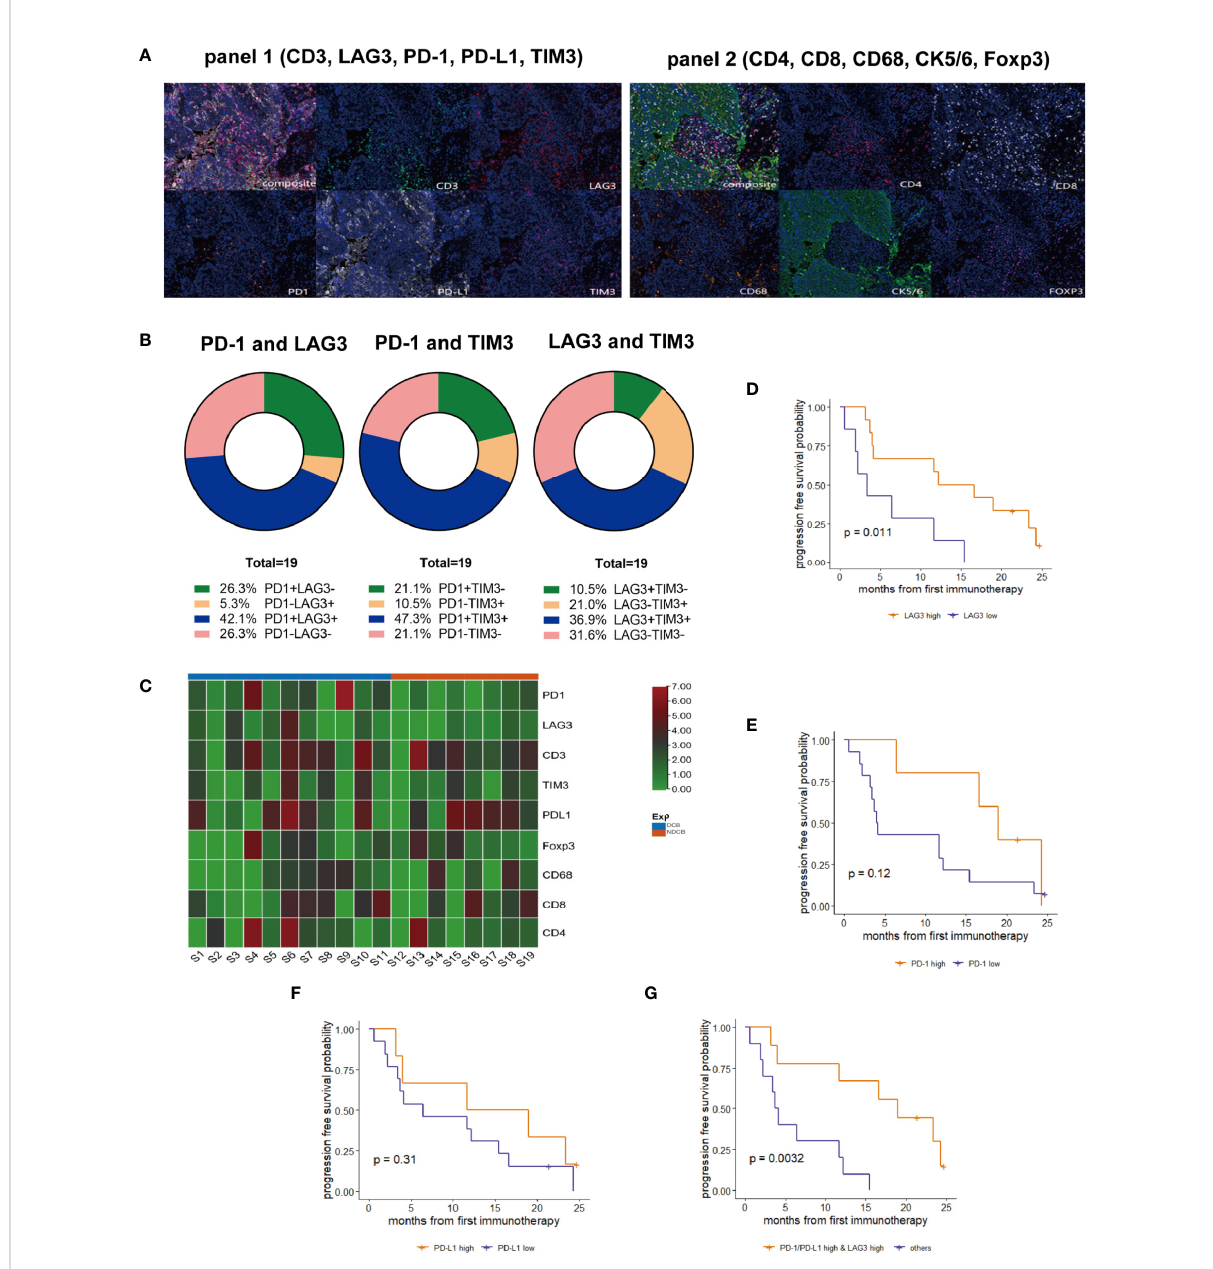
FIGURE 3 Expressions of PD-1, PD-L1, and LAG3 and their correlation in response to ICI treatment in PLELC. (A) Representative multiplexed immunohistochemistry (mIHC) staining for PD-1, PD-L1, LAG3, TIM3, and CD3 (panel 1; left), and CD4, CD8, CD68, FOXP3, and CK (panel 2; right). (B) Co-expression of PD-1, LAG3, and TIM3 of mIHC for 19 ICI-treated PLELC patients. (C) Heatmap for PD-1, LAG3, CD3, TIM3, PD-L1, Foxp3, CD68, CD8, and CD4 expressions in mIHC in 19 PLELC-DCB and NDCB patients. (D – G) PFS in PLELC with high expression of LAG3; PD- 1; PD-L1, and PD-1/PD-L1 and LAG3 versus